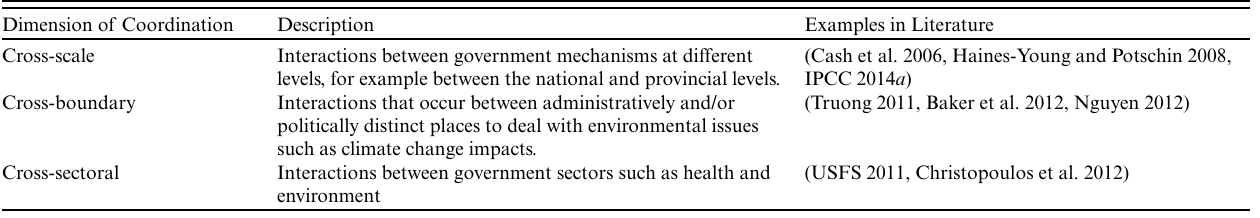
Table 1 . Three dimensions of